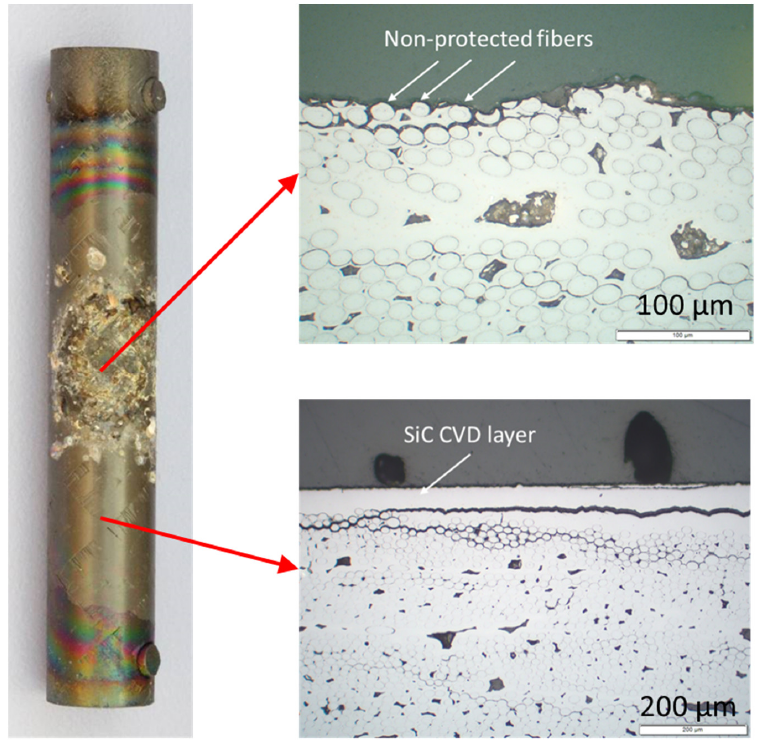
Figure 5. Post-test appearance of the sample after the transient test up to 1845 °C and optical micro- graphs from the failure region in the middle of the sample and from the non-failure region below.